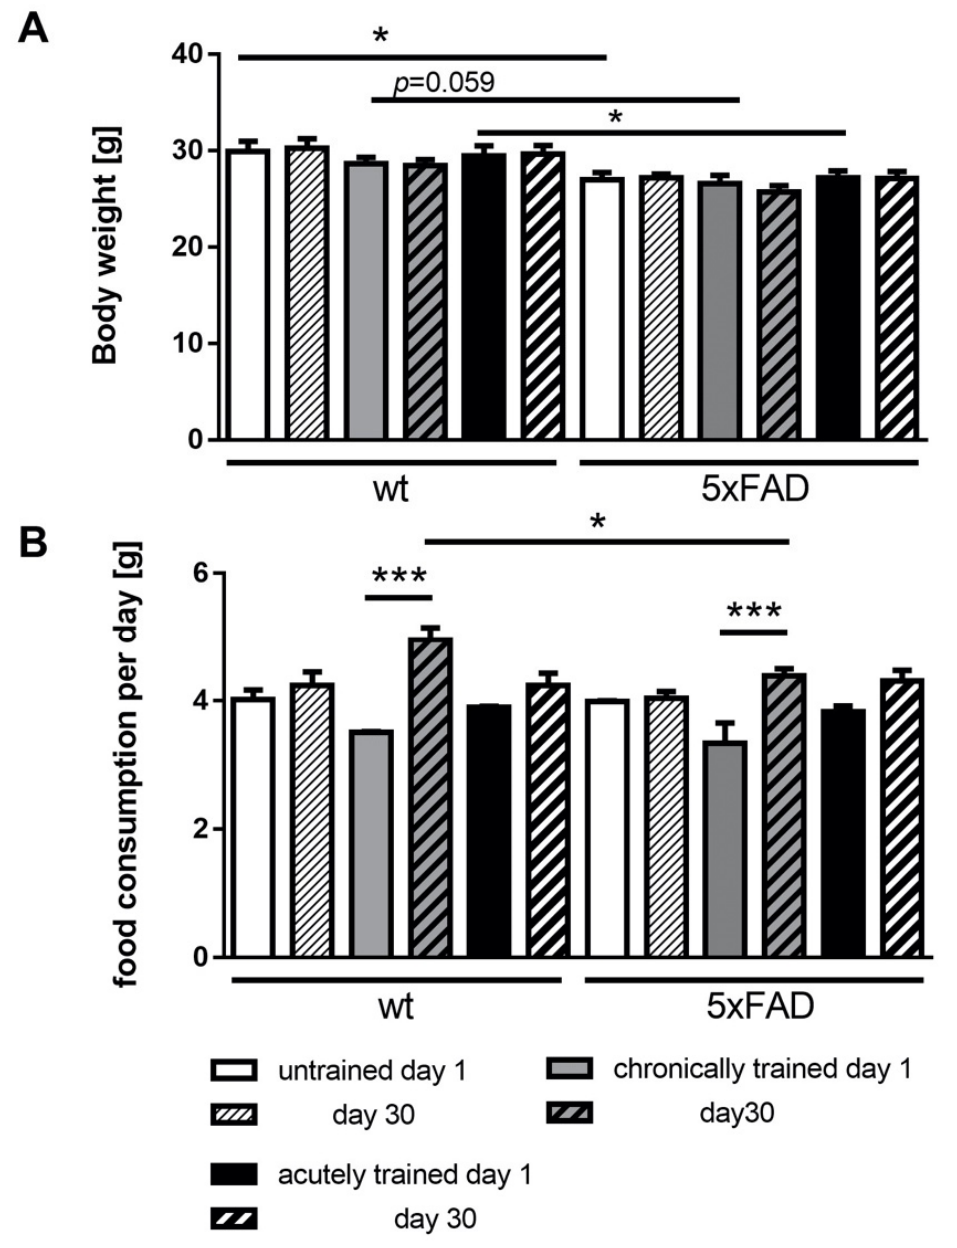
Figure 2. Bodyweight development and food intake of 5xFAD and wild-type mice depending on physical training. ( A ) Body weight was measured at the same time of the day two times weekly. Here, the start weight and the weight at the end of the experiment are indicated. ( B ) Food consumption was measured weekly and is calculated per day. Data are presented as mean + standard error of the mean (SEM) ( n = 6 for untrained and acutely trained, n = 7 for chronically trained mice). Statistical analysis: ordinary one-way ANOVA with the Fisher’s least significant difference (LSD) test (* p < 0.05; *** p < 0.001).